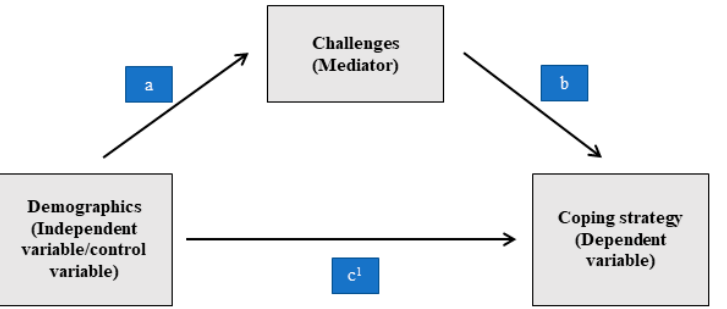
Figure 1. Proposed mediation path to explain association between demographics of healthcare worker, challenges faced by them and their coping response.